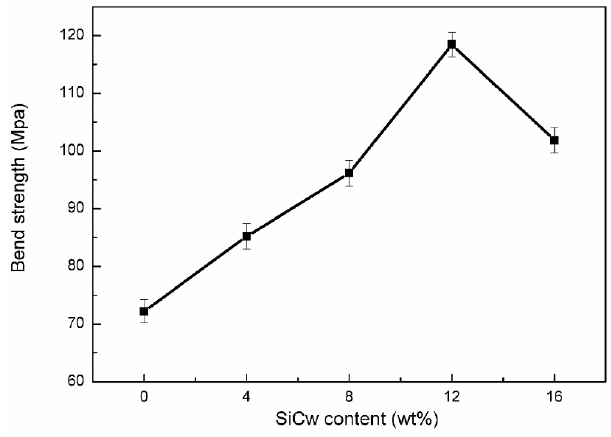
Figure 2. Bending strength of the SiCw/hydro-epoxy composites.